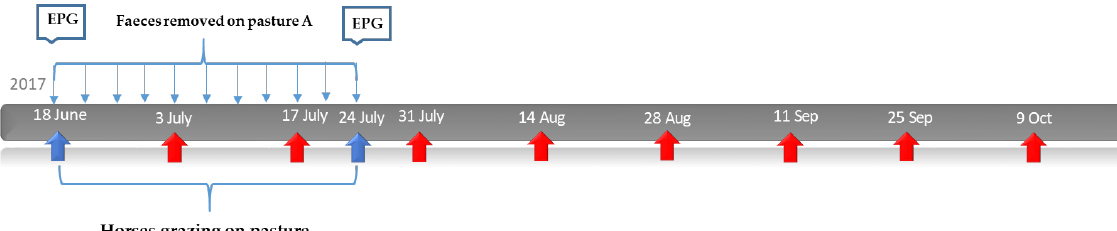
Figure 1. Faecal removal study, 2017 : Timeline over the study design. Horses were allowed to graze every other day in pastures A and B, respectively, during a five week period, with number of eggs per gram (EPG) obtained at the start and end of the grazing period. Faeces were removed twice weekly from pasture A only during this five week period (narrow blue arrows). Grass samples for harvesting third stage larvae (L3) were collected every other week, starting on 3 July (red arrows).